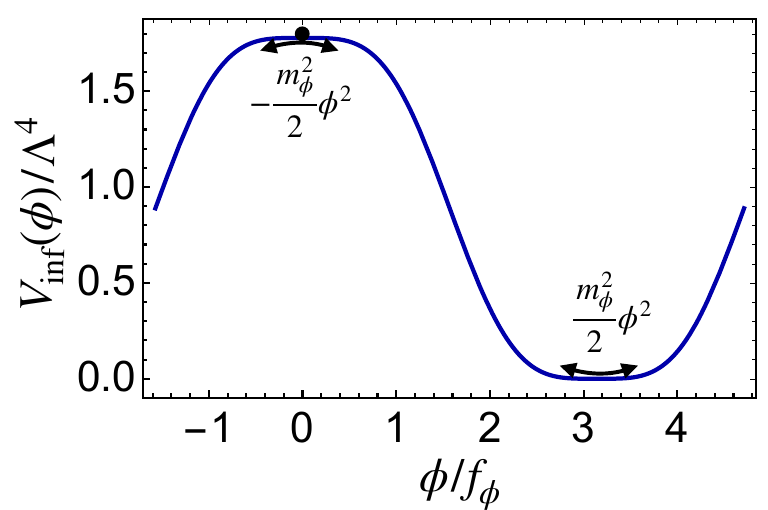
Figure 1 . The ALP potential for n = 3 with θ ≈ 0 and κ ≈ 1 . The curvatures of the potential at the maximum and minimum are equal to each other but with an opposite sign. The slow- roll inflation takes place around the hilltop of the potential while the ALP excitation around the minimum contributes to